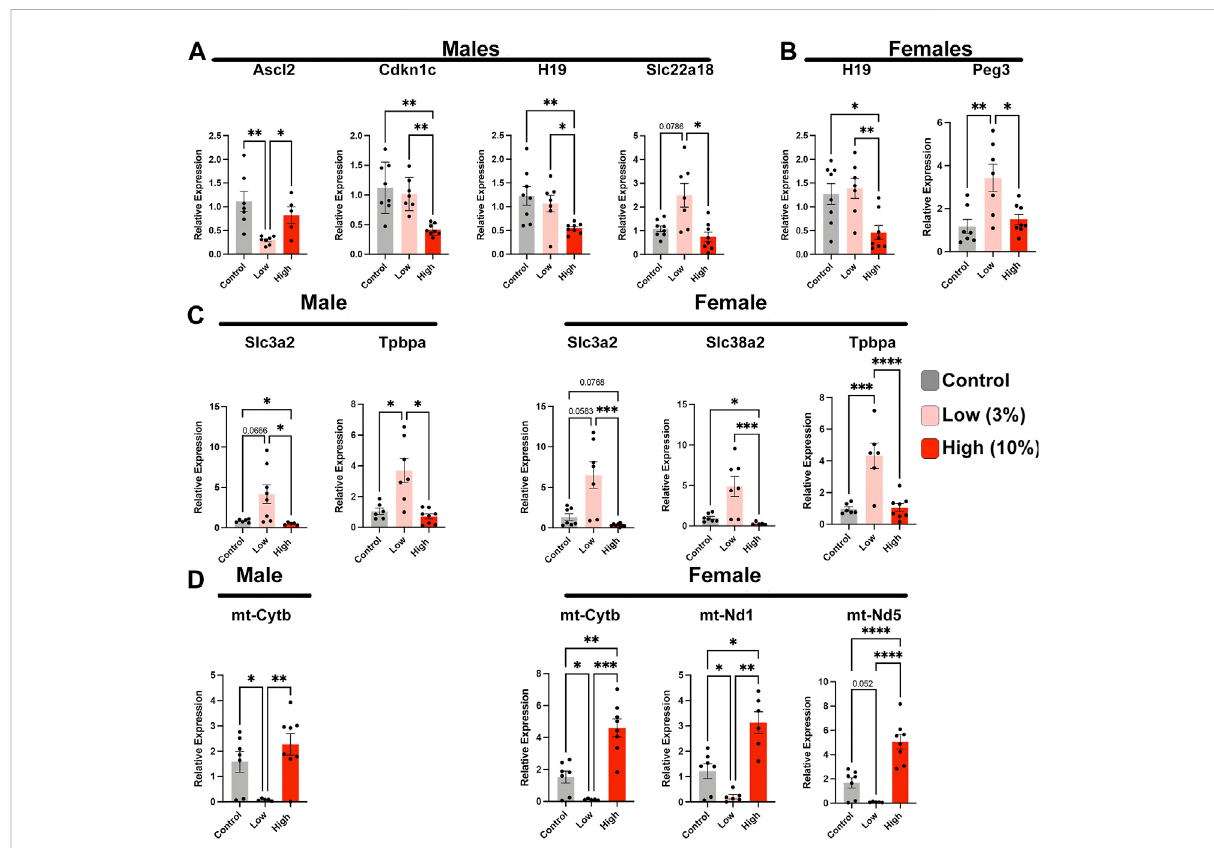
FIGURE 8 Paternal alcohol exposures induce alterations in placental gene expression. Analysis of imprinted gene expression in the placentae of (A) male and (B) femaleoffspringofControlandEtOH-exposedsiresintheLow-andHigh-concentrationtreatmentgroups. (C) Expression analysisofcritical placentalnutrienttransportersinmaleandfemaleoffspringsiredbyControl,Low-,andHigh-concentrationethanolexposedmales. (D) Comparison ofmitochondrial-encodedtranscriptsinplacentaederivedfromthemaleandfemaleoffspringofsiresexposedtotheControl,Low-,andHigh- concentrationethanoltreatments.WeanalyzedgeneexpressionusingRT-qPCR.Geneexpressionwasnormalizedtotranscripts encoding Pgk1 and Ywhaz ;( n =8).Foranalysis,weusedaone-wayANOVAoraWelchANOVA.Ifdatawerenotnormallydistributed,weusedanon-parametricKruskal- Wallis test. Error bars represent the standard error of the mean, * p < 0.05, ** p < 0.01, *** p < 0.001, **** p <